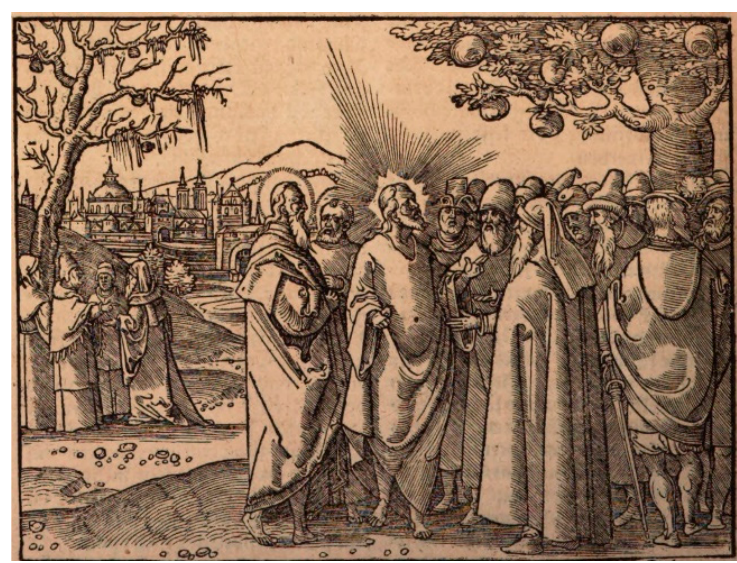
Figure 3. Hans Brosamer, Warning against false prophets [H 1047], ca. 1544, in (Luther 1544c) part 2, fol. CCXXIXv (Munich, Bayerische Staatsbibliothek, 2 Hom. 306-3, urn:nbn:de:bvb:12-bsb-10 144065-2; NoC-NC/1.0).